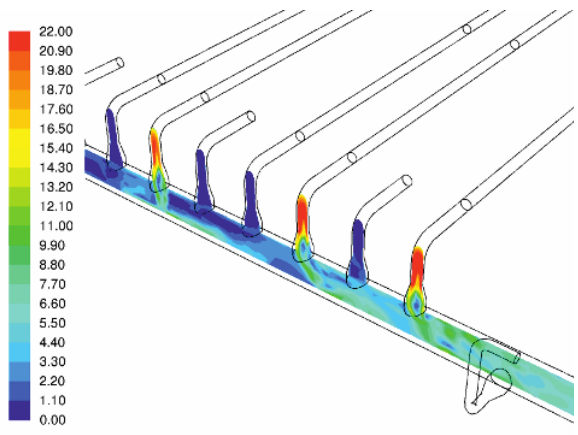
Figure 12: Instantaneous velocity in exit